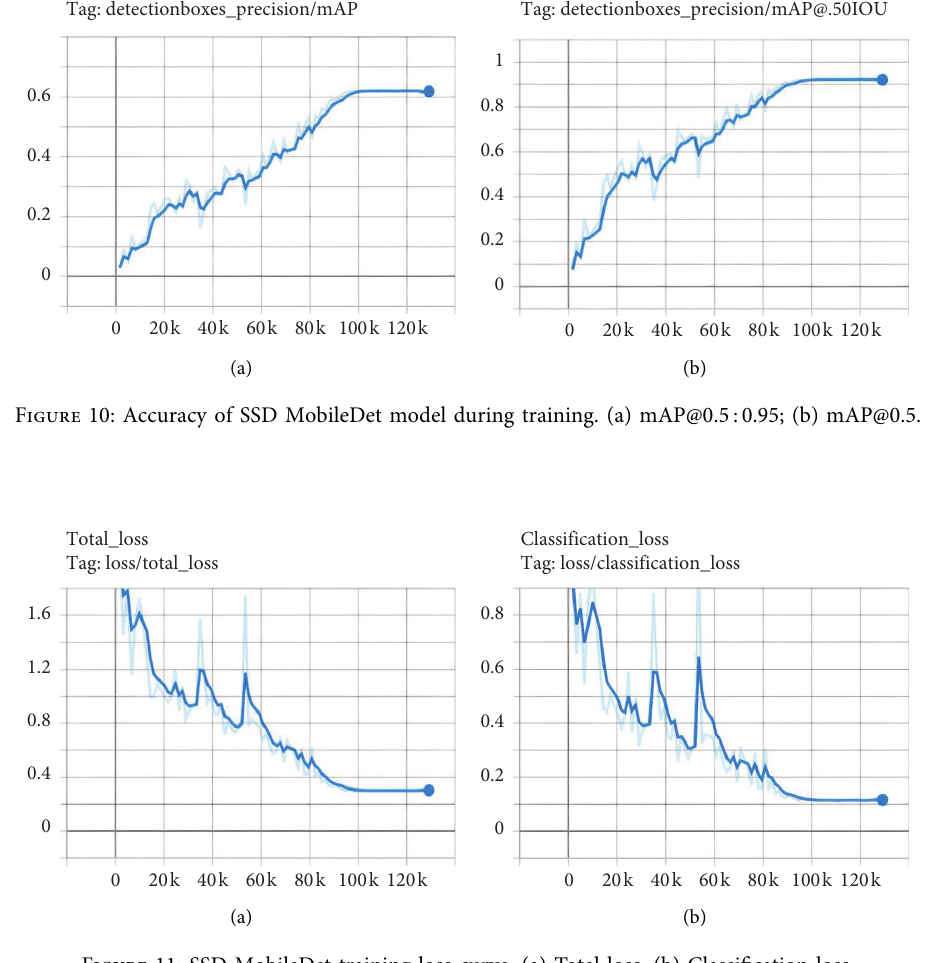
Figure 11: SSD MobileDet training loss curve. (a) Total loss. (b) Classification loss.